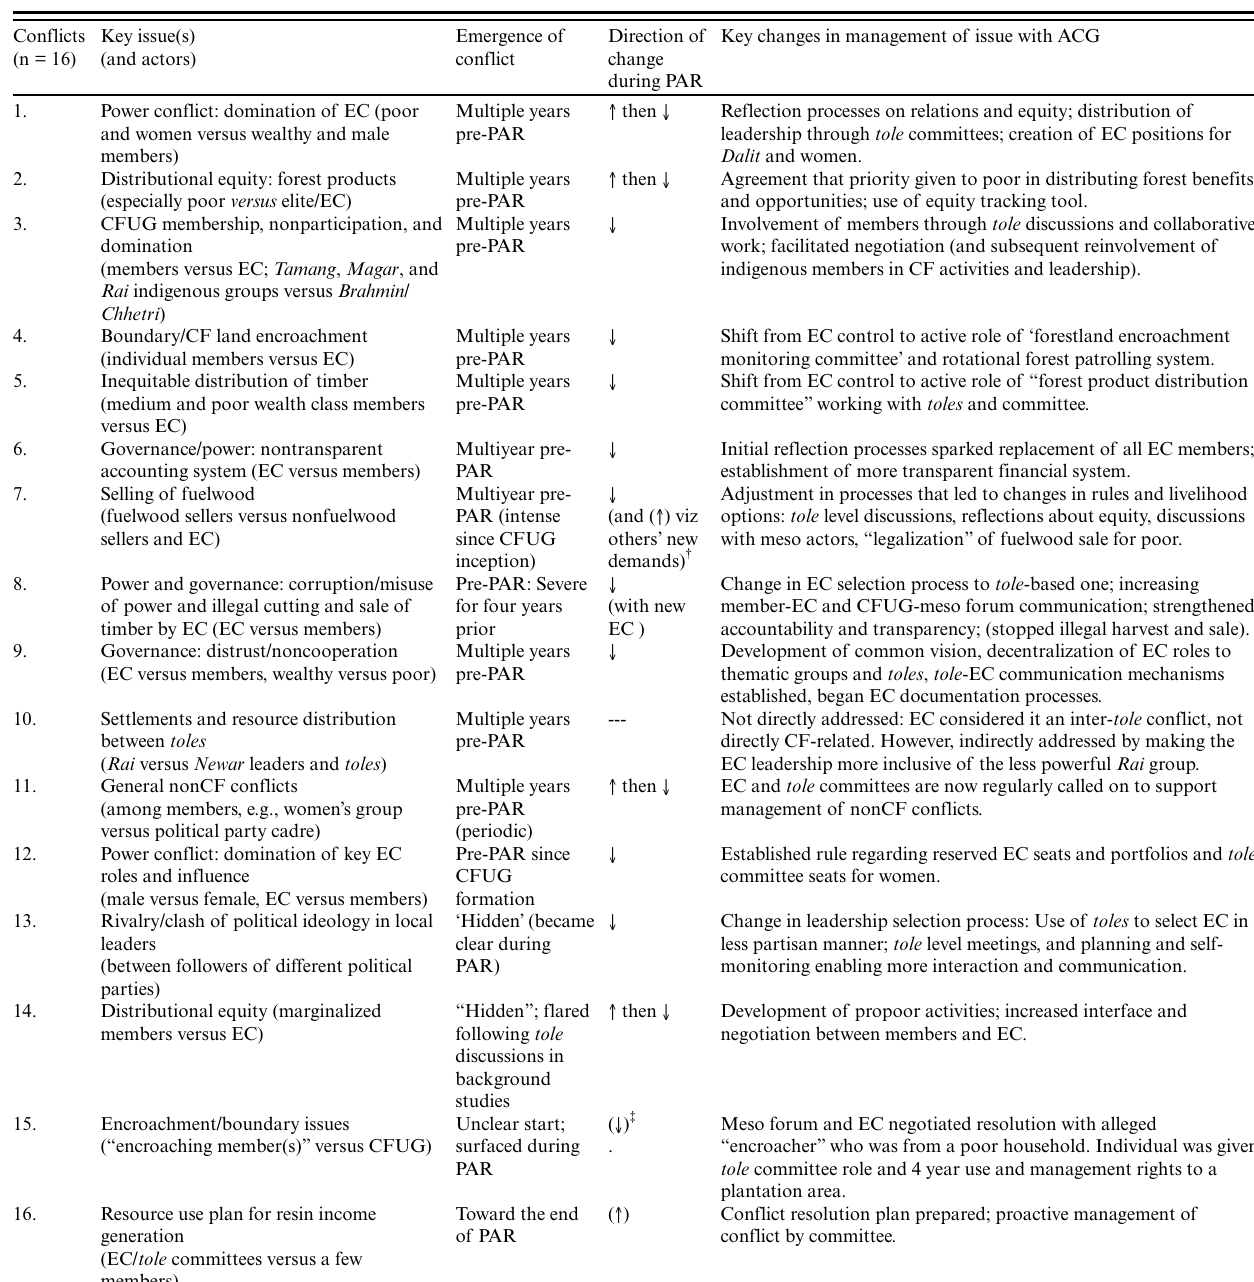
Table 4 . Main intra-community forest user groups (CFUG) conflicts: issues, actors, timing, and evolution (n = 11). Notes: PAR = participatory action research; ACG = Adaptive collaborative governance; EC = executive committee; CF = community forest(ry); CFUG = community forestry user group; ↑ = increased conflict; ( ↑ ) = slightly increased conflict; ↓ = decreased conflict; ( ↓ ) = slightly decreased conflict. Sources: Focus group discussions, key informant interviews,